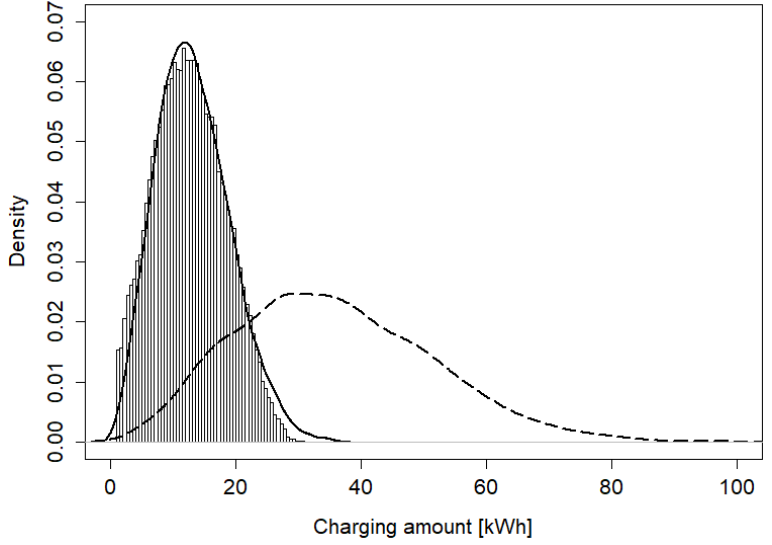
Figure 3. Distribution of EV charging amount per visit.